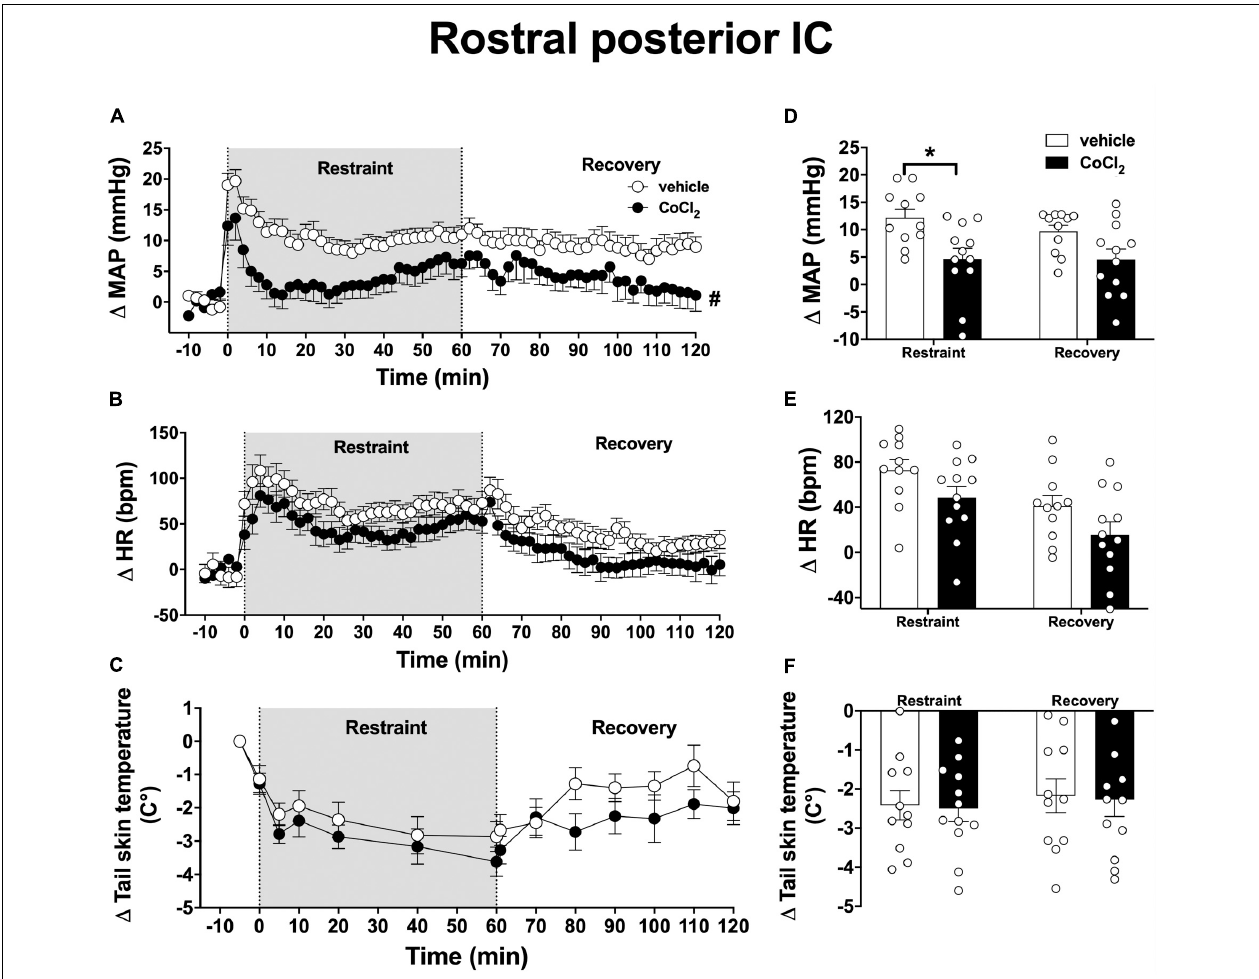
FIGURE 4 | Effect of bilateral microinjection of the non-selective synaptic inhibitor CoCl 2 into the rostral posterior subregion of the insular cortex (IC) on mean arterial pressure (MAP), heart rate (HR), and tail skin temperature responses evoked by an acute 60-min session of restraint stress. (A–C) Time-course curves of changes on MAP ( (cid:49) MAP), HR ( (cid:49) HR), and tail skin temperature ( (cid:49) tail skin temperature) evoked by acute restraint stress in animals treated bilaterally into the rostral posterior IC with vehicle (saline, 100 nl, n = 11) or the non-selective synaptic inhibitor CoCl 2 (1 mM/100 nl, n = 12). Circles represent the mean ± SEM. # p < 0.05 over the entire restraint and recovery period compared to vehicle group. Two-way ANOVA. (D–F) Mean of (cid:49) MAP, (cid:49) HR, and (cid:49) tail skin temperature during the entire restraint and recovery periods in animals treated bilaterally into the rostral posterior IC with vehicle ( n = 11) or CoCl 2 ( n = 12). Bars represent the mean ± SEM. * p < 0.05 compared to vehicle group. Two-way ANOVA followed by Bonferroni post-hoc